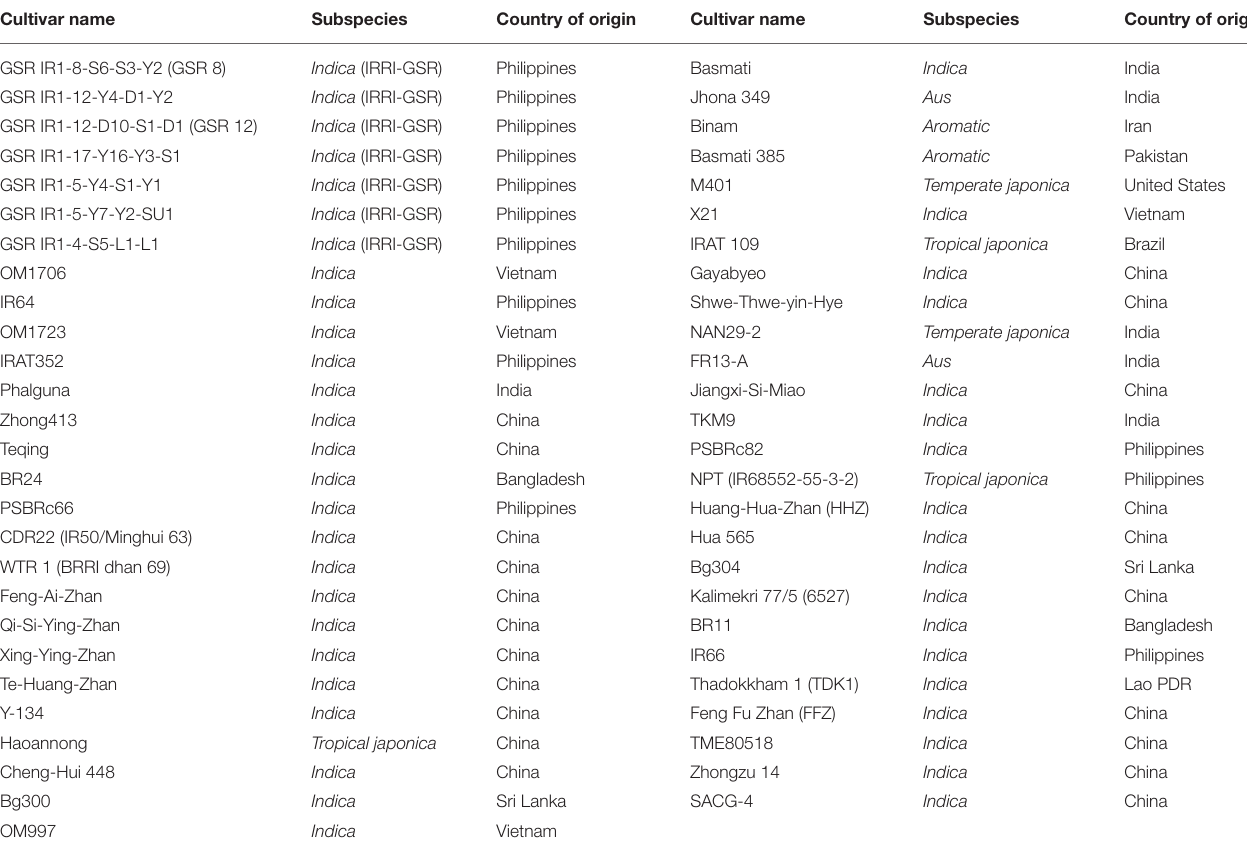
TABLE 1 | Description of plant cultivars used for arsenic tolerance screening. Cultivar